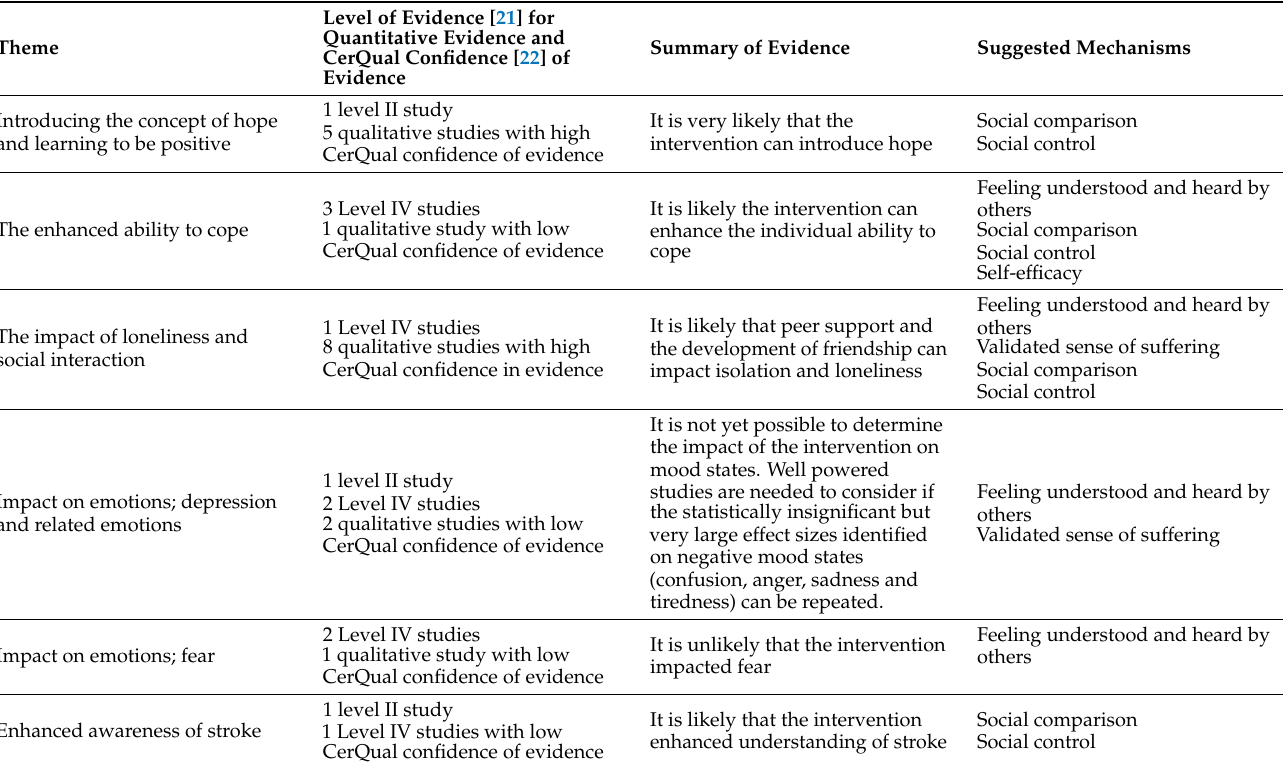
Table 1. Summary of